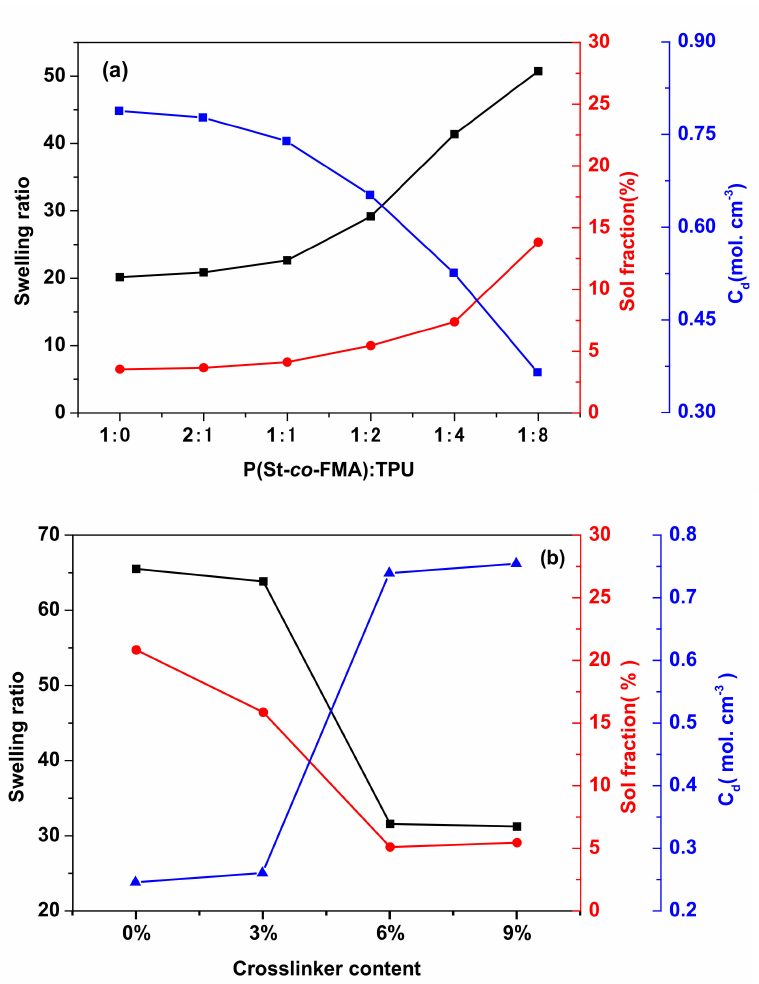
Figure 6. The swelling ratio, sol fraction and cross-link density of the semi IPNs series ( a ) with different ratios of P(St- co -FMA)/TPU, ( b ) with different crosslinker